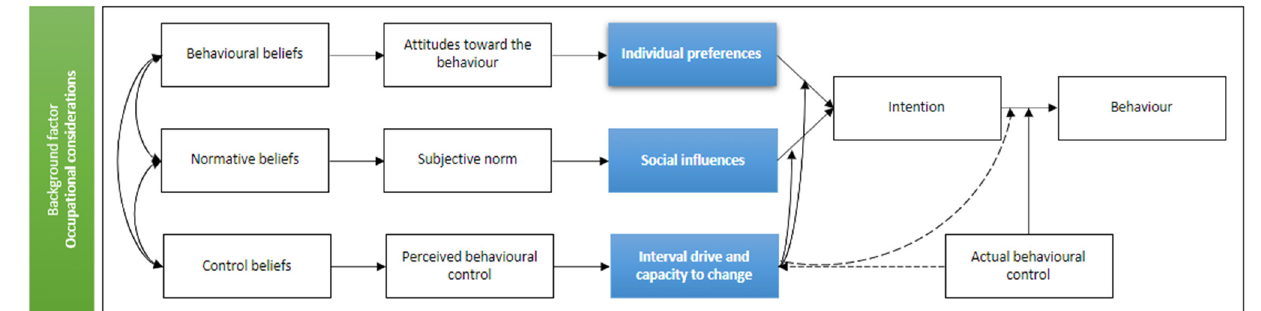
Figure 1. Themes mapped to the theory of planned behavior (Adapted from Ajzen 2019) [30].